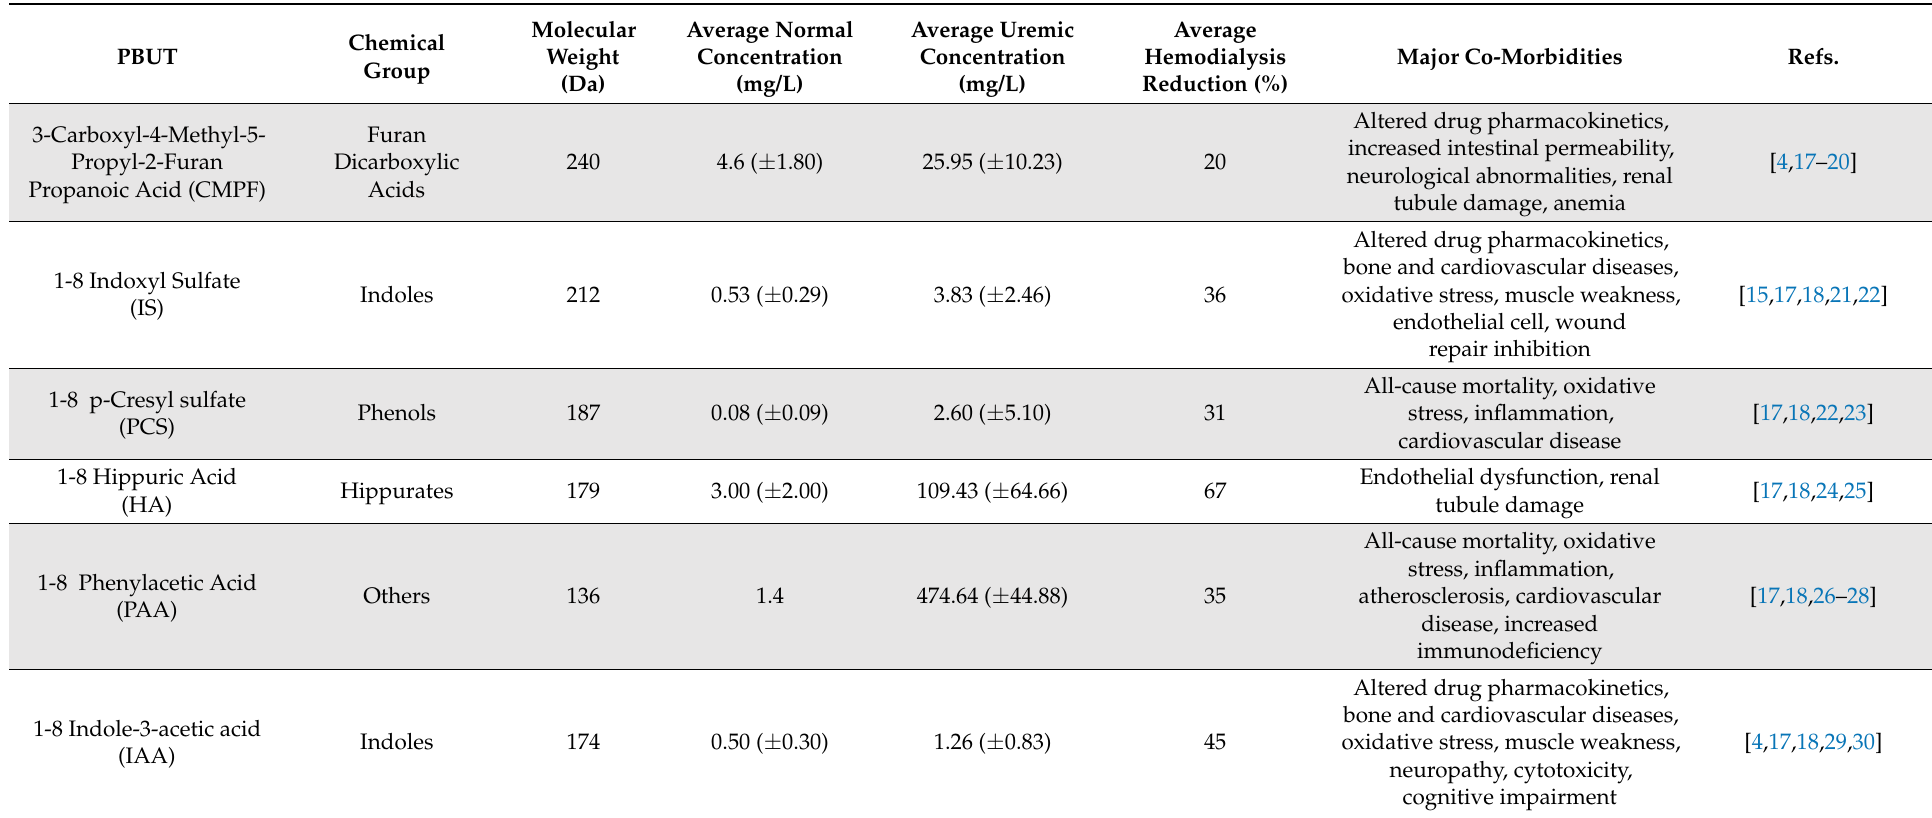
Table 1. Physical properties of protein-bound uremic toxins, significance in CKD patients, and major co-morbidities caused by the accumulation in the blood